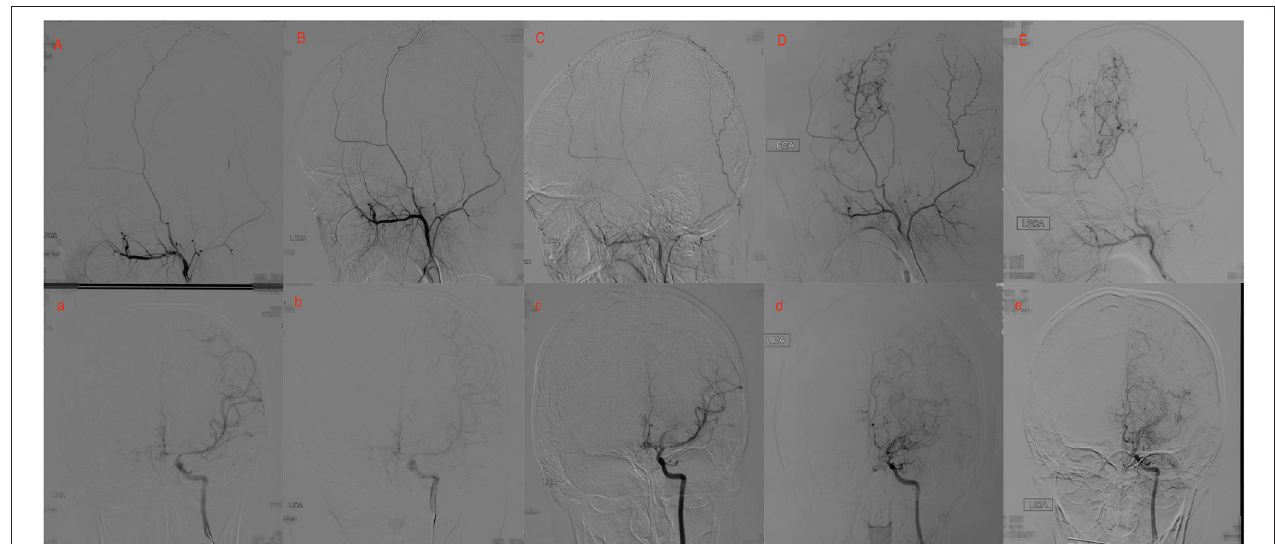
FIGURE 2 | Twenty yrs, female. (A) a: Preoperative angiography showed mild stenosis at the proximal to the left middle cerebral artery (MCA) and anterior cerebral artery (ACA; Suzuki gradeI), and well-developed left superficial temporal artery (STA). (B) b: Postoperative angiography 2.5 years after EDAS showed the stenosis was almost unchanged (Suzuki 1 gradeI), and no collateral circulation through EDAS was observed. (C) c: Postoperative angiography 3.5 years after EDAS showed remarkable progress in the stenosis of the proximal of MCA and ACA, and collateral circulation through EDAS began to develop. (D) d: Postoperative angiography 8 years after EDAS showed occlusion of left MCA and ACA with intensification of abnormal vascular networks (Suzuki grade III), and more than one-third of the MCA distribution was covered by collateral circulation through EDAS. (E) e: Postoperative angiography 10.1 years after EDAS showed occlusion of left MCA and ACA with minimization of abnormal vascular networks (Suzuki grade IV), and more than two-thirds of the MCA distribution was covered by collateral circulation through